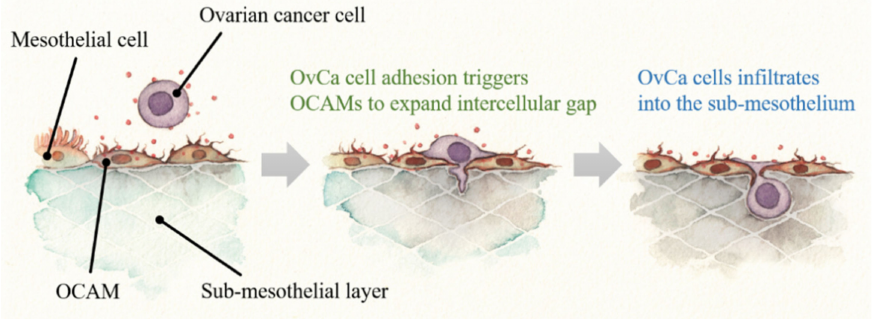
Figure 2. The model of trans-mesothelial migration of ovarian cancer (OvCa) cells. OvCa cells stimulate mesothelial cells (MCs) to transition into OvCa-associated MCs (OCAMs), which in turn enhance the adhesion of OvCa cells to mesothelial tissue. This adhesion triggers OCAMs to expand the intercellular gap by their own migration. Then, OCAMs invite the OvCa cells to pass through the intercellular gap and enter the sub-mesothelial